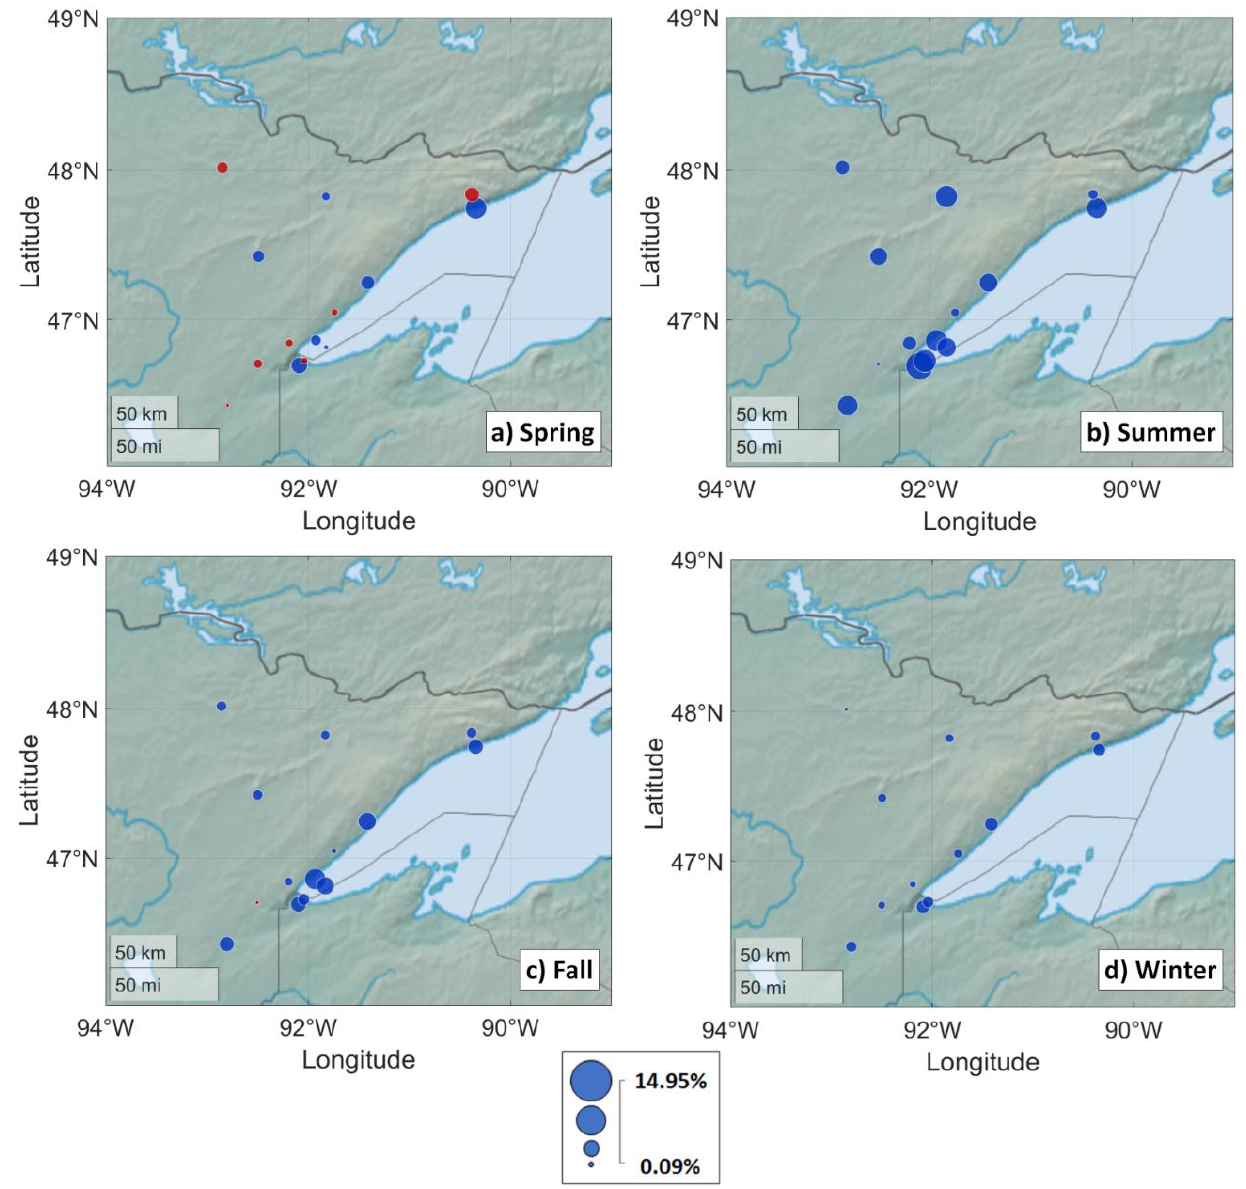
Figure 4. As in Figure 3, except for average relative humidity change by season: ( a ) spring; ( b ) sum- mer; ( c ) fall; ( d ) winter. Red (blue) bubbles indicate increasing (decreasing) relative humidity. For a different perspective which is expected to yield the same result, the percentage of cold fronts associated with warming was also calculated for two lake-influenced/inland site pairs (GNA/CKC and DYT/DLH). As above, it is hypothesized that a larger percentage of frontal events will be associated with warming at coastal sites in spring and summer. This analysis also reduces any diurnal bias resulting from cold fronts coming through during different times of day. Results indicate that coastal sites (blue lines in Figure 5) have more post-frontal warming events in spring and summer, while the percentages of warming events in fall and winter become more comparable for adjacent sites (pairs of dashed and bold lines in Figure 5). Percentage of fronts associated with warming seasonally changes approximately in parallel for the inland sites (orange lines in Figure 5) and separately for the coastal sites (blue lines in Figure